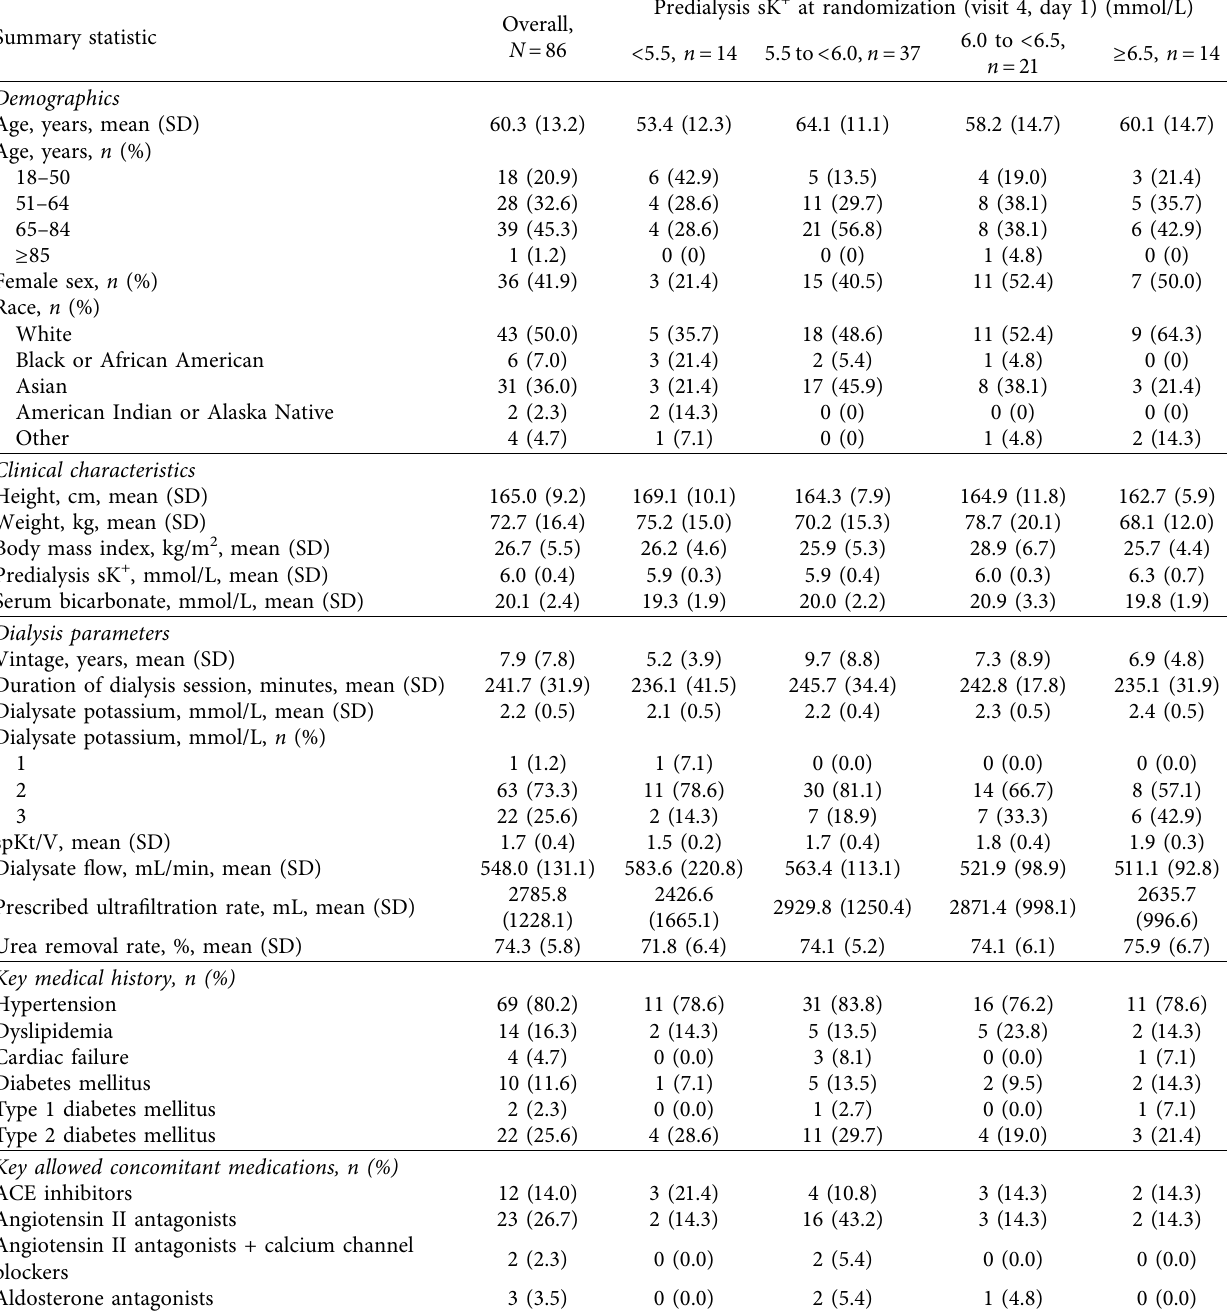
Table 1: Baseline (visit 1, day − 7) characteristics of placebo